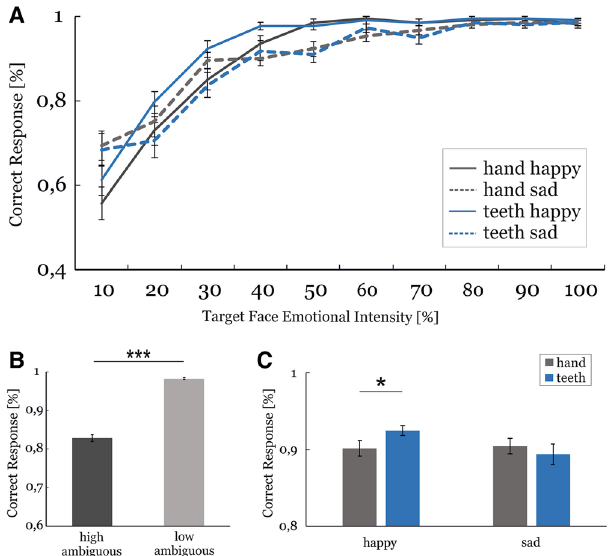
Figure 2. Accuracy of WM Performance. ( A ) Percent correct responses for each emotional intensity of the target face during the hand condition for happy (solid grey) and sad (dashed grey) faces and during the teeth condition for happy (solid blue) and sad (dashed blue) faces. ( B ) Percent correct responses for highly (left) and less (right) ambiguous emotional faces. In comparison to less ambiguous faces, memory accuracy for highly ambiguous faces was significantly reduced. ( C ) Percent correct responses across all intensity levels for happy (left) and sad (right) faces during the hand (grey) and teeth (blue) FFM condition. Whereas FFM did not influence the memory accuracy to sad faces, FFM improved the accuracy for happy faces during the teeth condition. Happy faces were more often correctly remembered in the teeth compared to the hand condition. Error bars represent standard errors (SE). *** p < .001, * p <